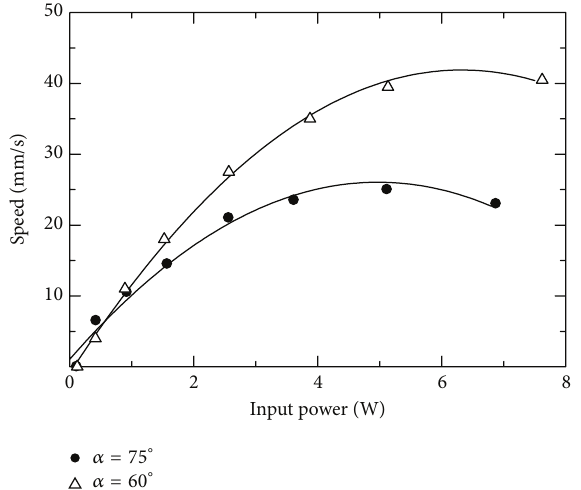
Figure 8: Relationship between load mass and